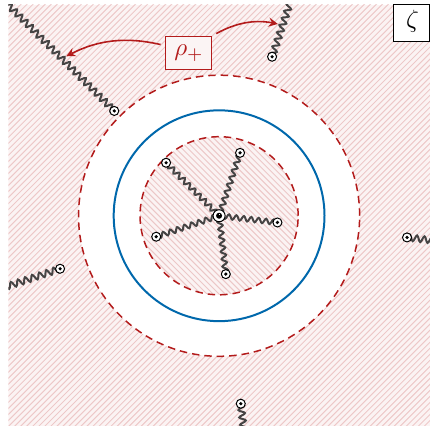
Figure 3. In this paper, we will focus on densities (pictured here as black lines) that extend radially outwards from the origin in the complex ζ -plane. This will be the case in all of the examples we consider, and this restriction allows us to find simple expressions for the effective potential in terms of ρ + ( ζ ) , the zero density outside the physical